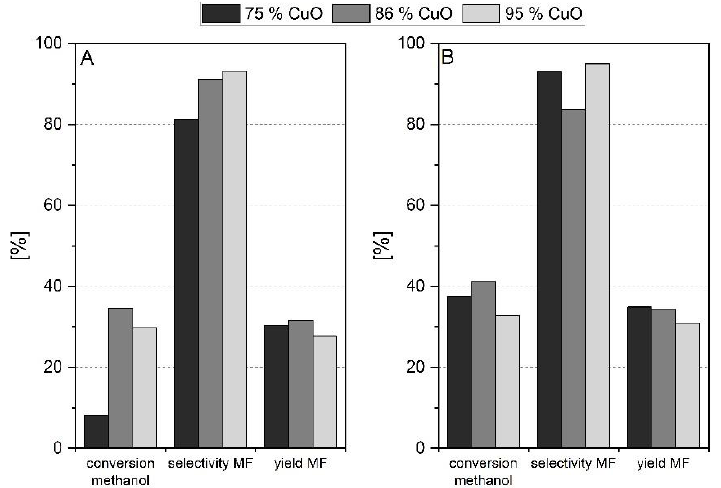
Figure 5. Influence of CuO content of CuO/Cr 2 O 3 catalyst without ( A ) and with ( B ) sodium for dehydrogenation of methanol at 180 °C and 0.1 MPa [41].